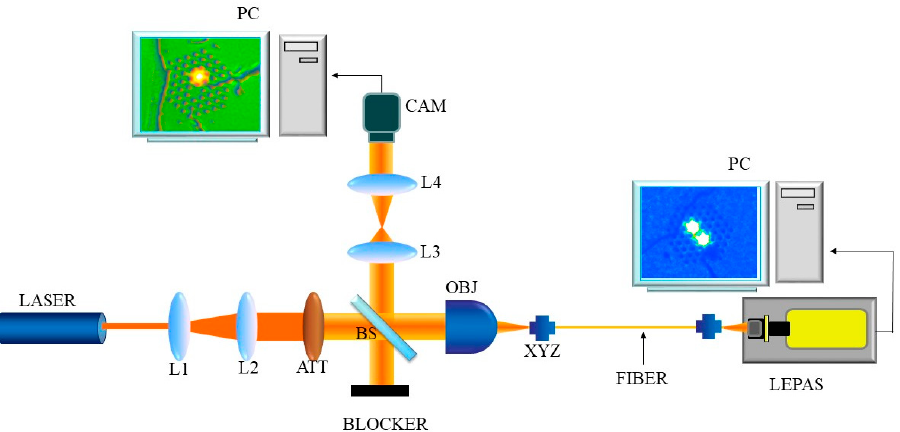
Figure 4. Schematic diagram of the experimental set-up used to excite selectively the fabricated mPOFs. L1: plane-concave lens; L2: symmetrical convex lens; ATT: attenuator; L3: symmetrical convex lens; L4: symmetrical convex lens; BS: beam splitter; OBJ: 0.4–NA objective lens; CAM: digital camera; XYZ: xyz linear translation stage. The near field pattern of five mPOF samples of 38.0 cm in length were measured at two different wavelengths: 594.0 and 612.0 nm. For each fiber sample and